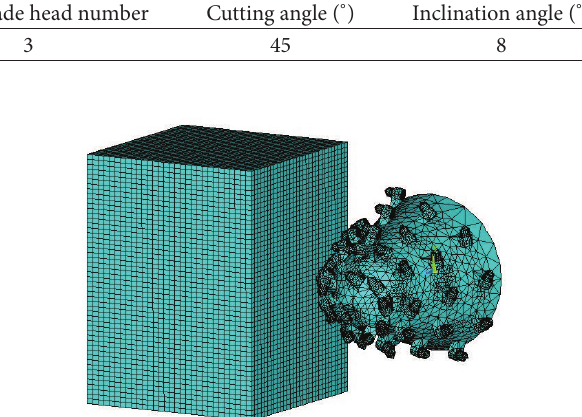
Figure 3: FE model of cutting process with a single pick.